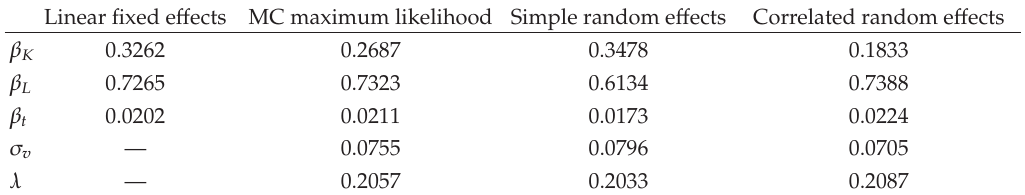
Table 2: Results for the EU-KLEMS